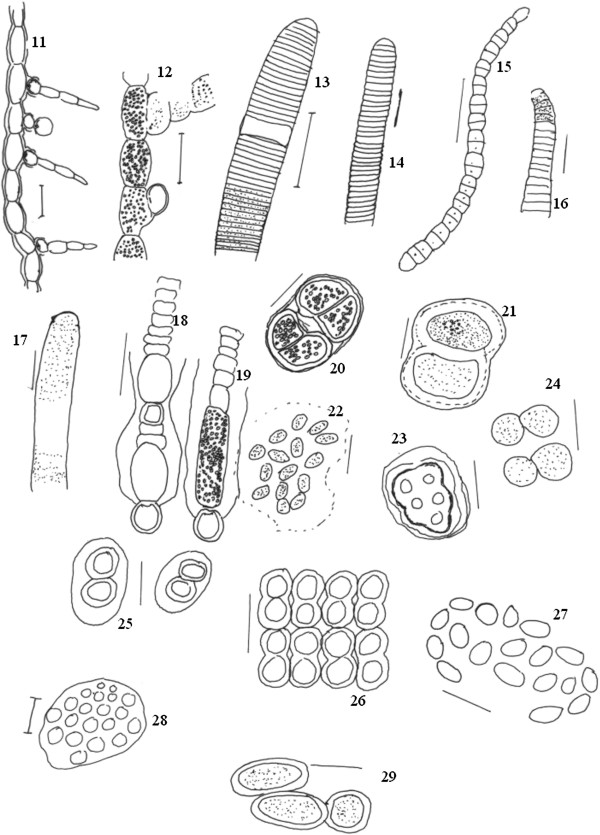
Camera Lucida diagram, of cyanobacterial species 11. Nostochopsis radians12. Nostochopsis lobatus13. Oscillatoria simplicissima14. Oscillatoria jenesis15. Oscillatoria sp.16. Oscillatoria princeps17. Oscillatoria limosa18. Gloeotrichia sp.19. Gloeotrichia natans20. Chroocococcus tanex21. Chroococcus limneticus22. Gloeocapsa gelatinosa23. Gloeocapsa sp.24. Chroococcus turgidus25. Gloeocapsa sp.26. Merismopodia sp.27. Aphanothece conferta28. Coelosphaerium sp.29. Gloeothece rupestris. Scale bar 10 μm.